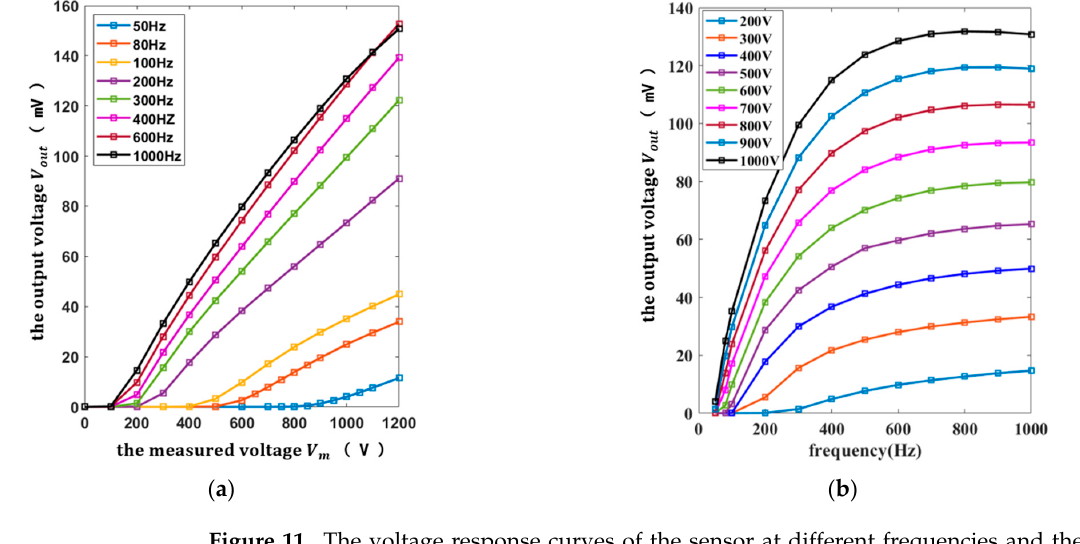
Figure 11. The voltage response curves of the sensor at different frequencies and the frequency response curves of the sensor at different voltages: ( a ) the voltage response curve of the sensor; ( b ) the frequency response curve of the sensor. ( b ) the frequency response curve of the sensor.